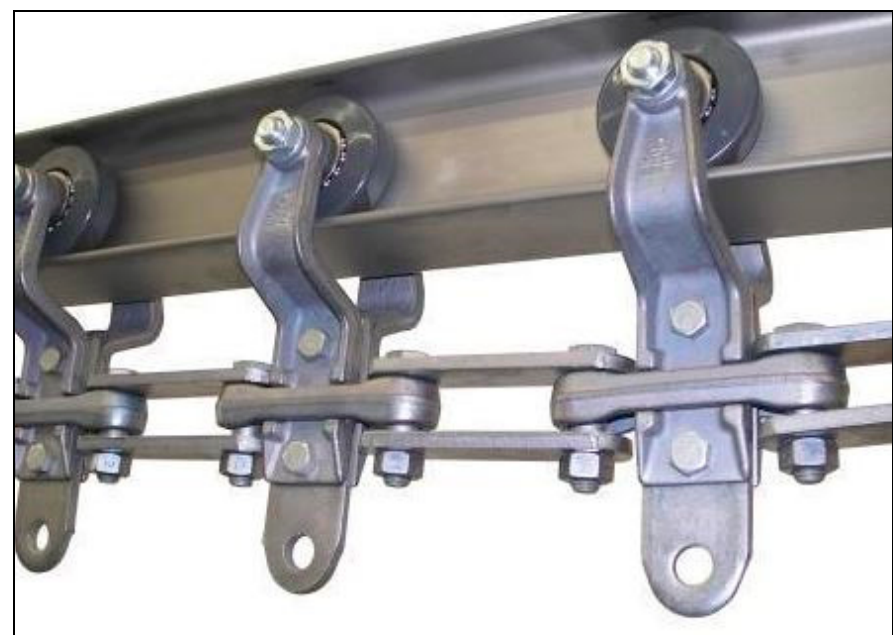
Figure 11. Overhead beam conveyor.